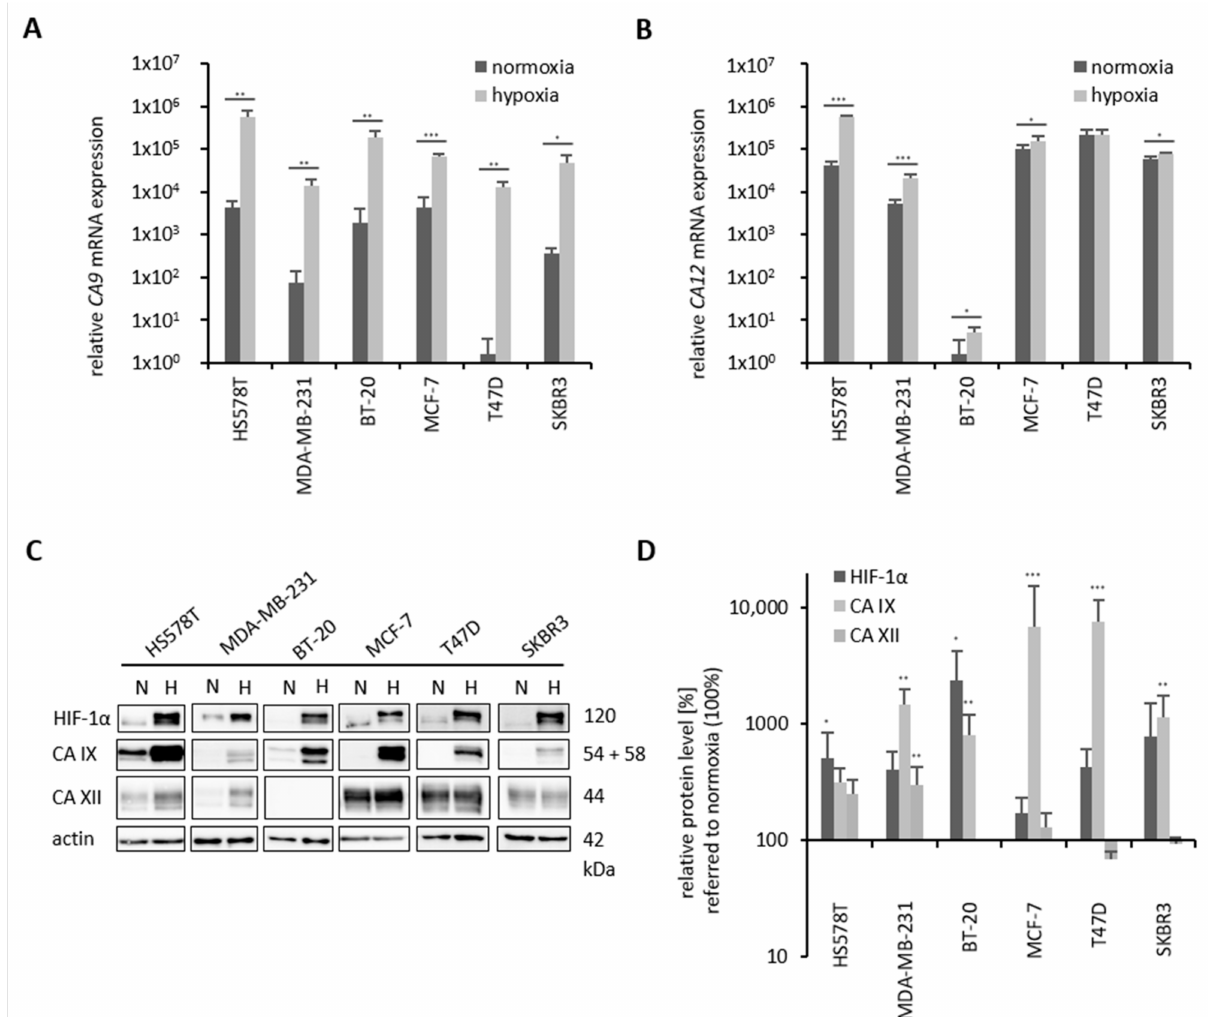
Figure 3. Influence of hypoxia on CA 9 and CA 12 mRNA and HIF-1 α , CA IX, CA XII protein expression levels. Breast cancer cell lines were cultured under normoxia (21% O 2 ) and hypoxia (0.1% O 2 ) for 24 h. RNA and protein were isolated from the cell lysates. RT-PCR was used to determine the mRNA expression levels of CA 9 ( A ) and CA 12 ( B ). HIF-1 α , CA IX and CA XII protein levels were verified by Western blot ( C ) and the influence of hypoxic conditions on HIF-1 α , CA IX and CA XII protein levels was quantified ( D ). Values determined from the hypoxic samples of each cell line were compared to the corresponding normoxic sample, which was set as 100%. Data (mRNA or protein level) represent mean values (+SD) of at least three independent experiments. Significant p values are highlighted with asterisks (* p ≤ 0.05, ** p ≤ 0.01, *** p ≤ 0.001). In Western Blot analysis actin was used as the loading